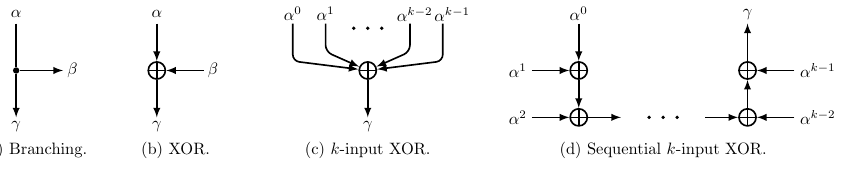
Figure 1: Linear